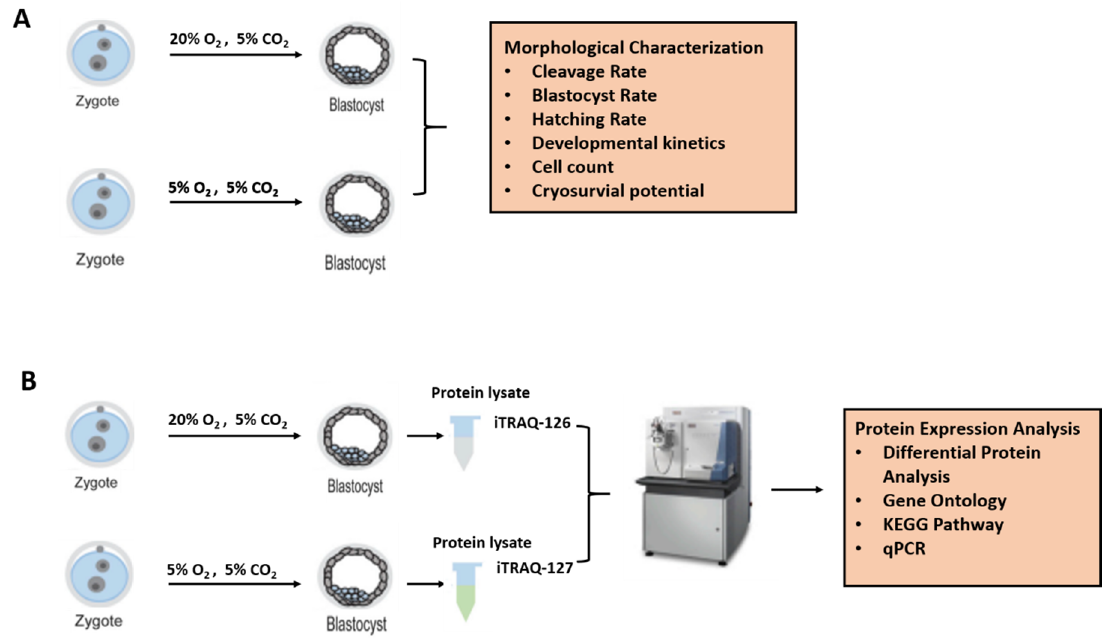
Figure 12. Schematic illustration of experimental design. Buffalo embryos were cultured in 5% or 20% oxygen and evaluated for morphological parameters of embryo development ( A ).